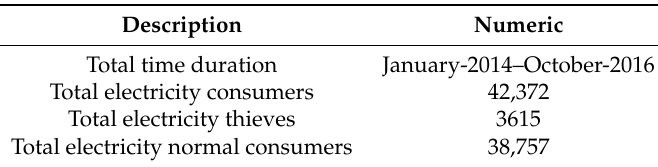
Table 1. SGCC dataset